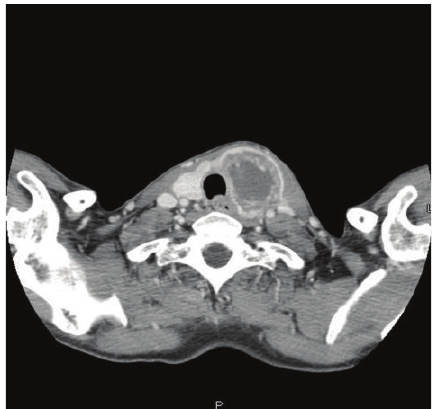
Figure 4: Fused fluorodeoxyglucose (FDG) positron emission tomography (PET) CT shows hypermetabolic left supraclavicular lymphadenopathy